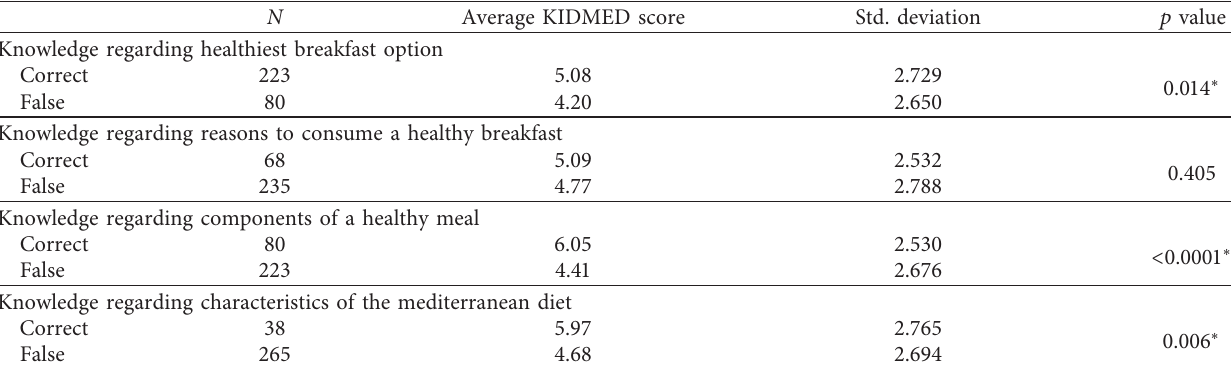
Table 2: Association between answers on nutritional knowledge questions and average KIDMED score among university students in Lebanon.